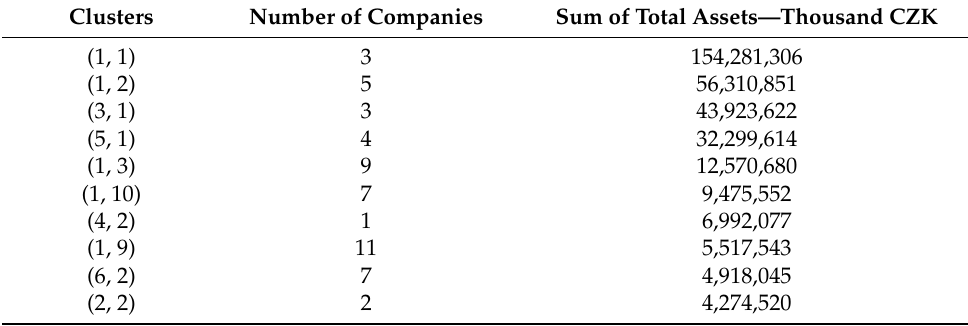
Table 12. Table of ten clusters with the highest total sum of assets for the year 2018. Clusters